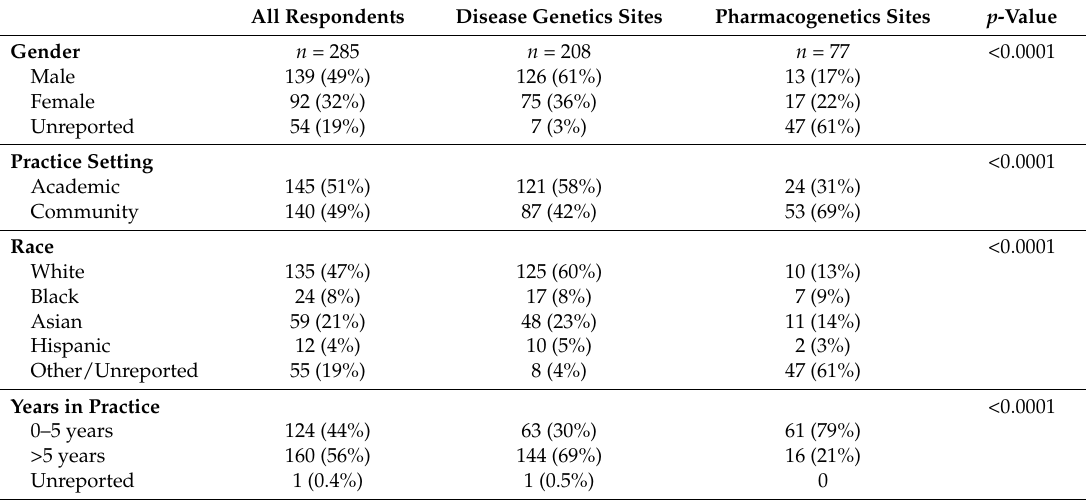
Table 2. Demographics of the survey